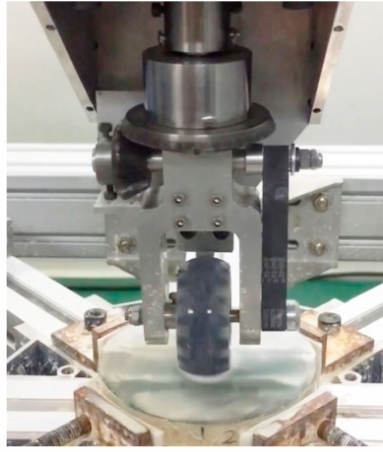
Figure 8. Processing device.